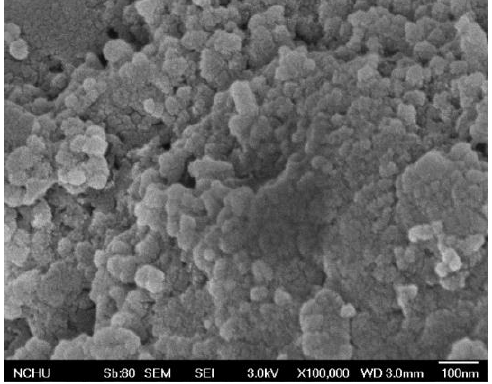
Figure 6. CNCs (carbon nanocapsules) picture measured by SEM.